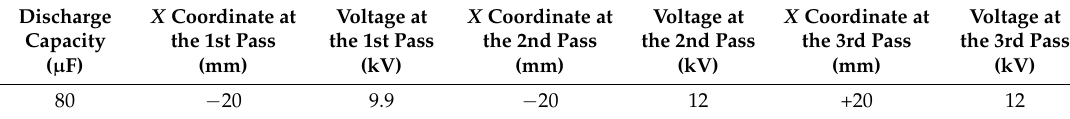
Table 2. Basic conditions in the simulation for electromagnetic incremental forming